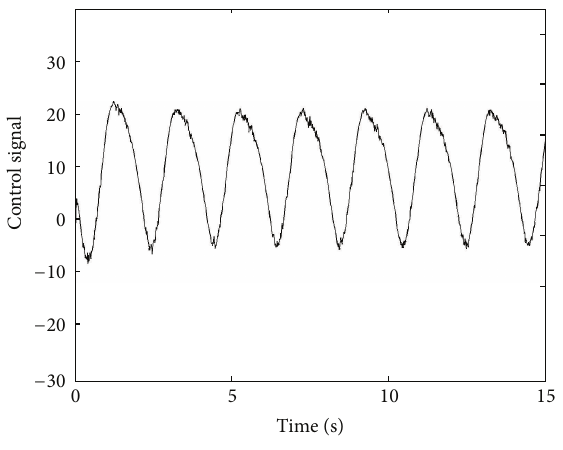
Figure 3: The control signal 𝑢(𝑡)